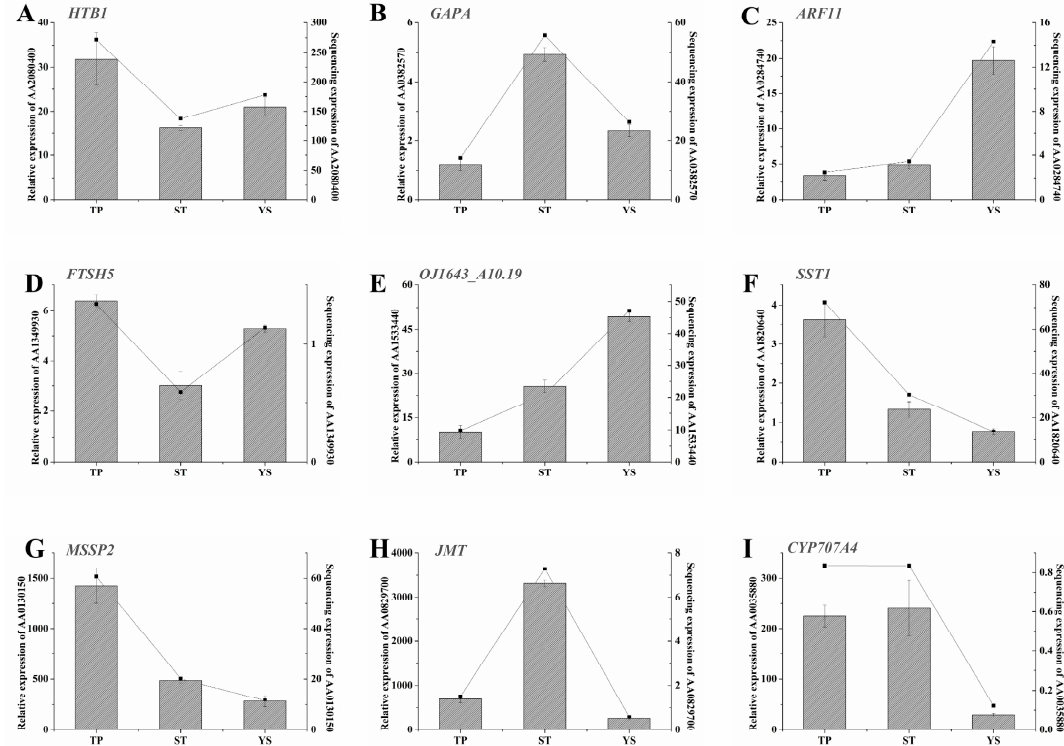
Figure 9. Spatiotemporal expression profiles of the nine DEGs in TPs (tiller primordia), STs (stem tips), and YSs (young spikes). ( A ) AA2080400 (Histone H2B.1); ( B ) AA0382570 (Glyceraldehyde-3-phosphate dehydrogenase A, chloroplastic); ( C ) AA0284740 (Auxin response factor 11); ( D ) AA1349930 (ATP-dependent zinc metalloprotease FTSH5, mitochondrial); ( E ) AA1533440 (Replication protein A 32 kDa subunit B); ( F ) AA1820640 (Sucrose: sucrose 1-fructosyltransferase); ( G ) AA0130150 (Monosaccharide-sensing protein 2); ( H ) AA0829700 (Jasmonate O-methyltransferase); ( I ) AA0035880 (Abscisic acid 8 and apos;-hydroxylase 4). Functional annotation and the other details of A-I were listed in Table S1. The actin gene was used as internal control. Left y -axis represented relative expression. Relative expressions were showed by histograms. Error bars indicated the standard deviation. Right y -axis represented expression value (FPKM) of transcriptome sequencing. Expression value was replaced by the average of three repetitions and showed by line charts. x -axis, the samples used for sequencing. All quantitative reverse transcription PCR (qRT-PCR) reactions were replicated three times.